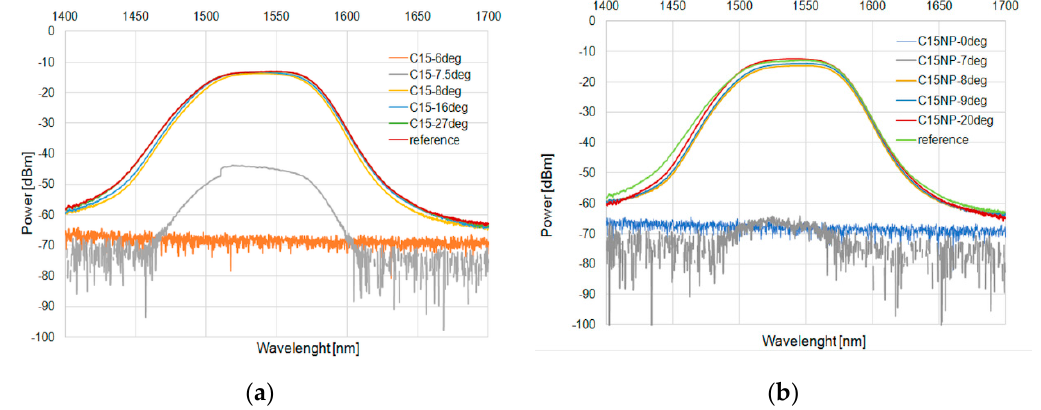
Figure 10. Cooling process in C15 ( a ) and with an admixture of NPs ( b ) for SLED 1400–1700 nm.